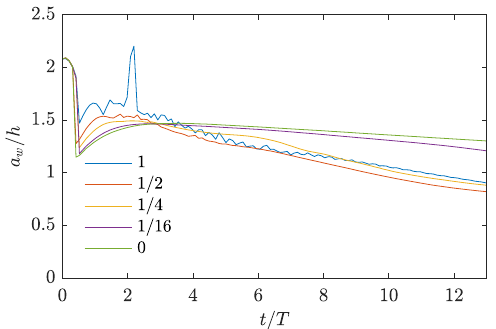
Figure 10. Wave amplitude as a function of time for different rota- tion rates ( f/f 0 in legend). All cases have Sc =